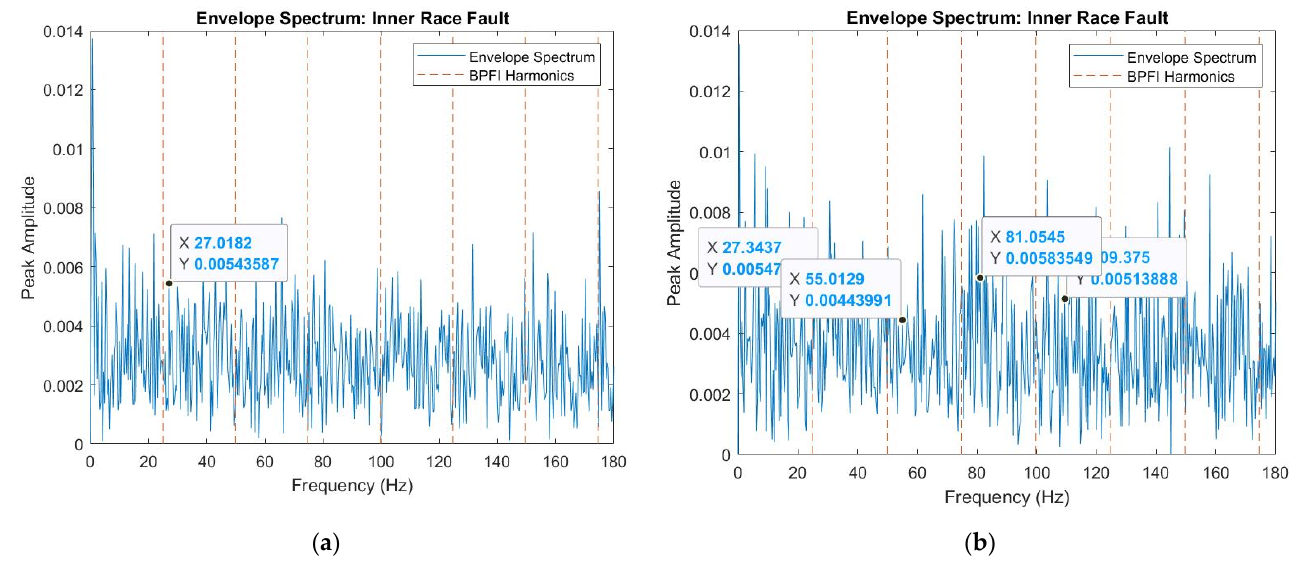
Figure 14. Acceleration envelop of a rolling bearing with damaged inner ring: ( a ) etalon bearing and ( b ) experimental bearing.